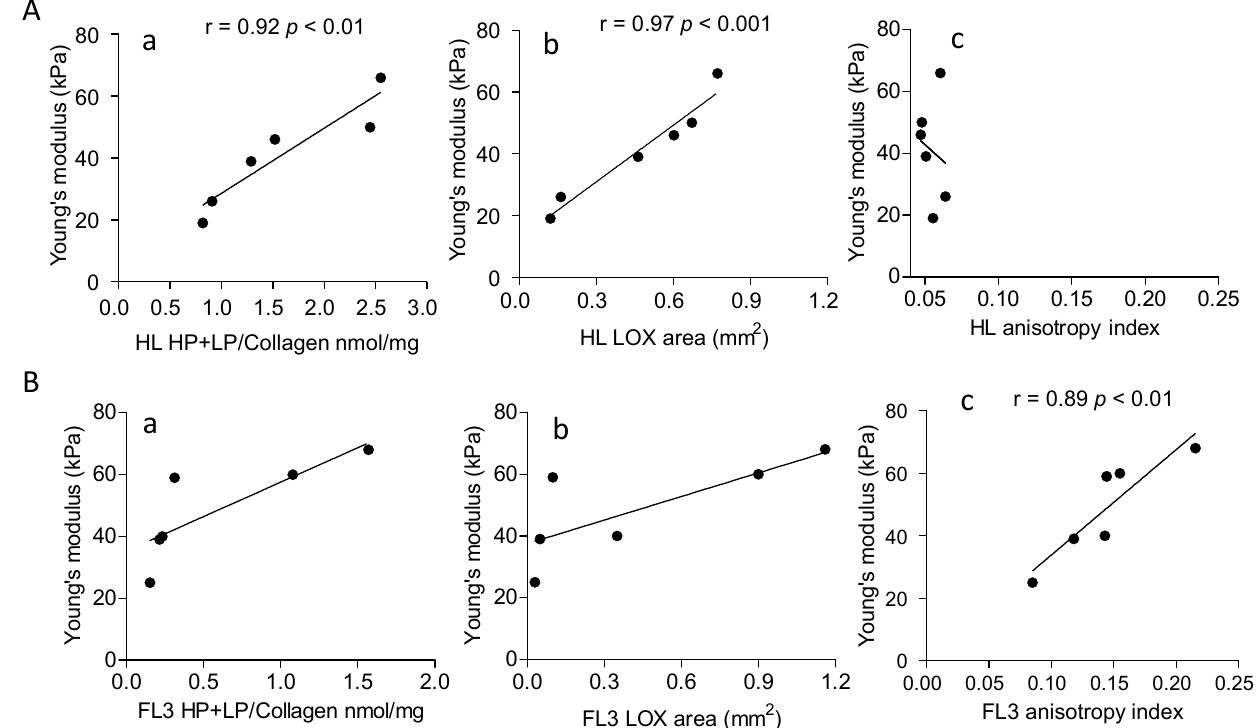
Figure 6. Correlation between Young’s modulus and collagen cross-linking, LOX expression or anisotropy in HL and NHL FL3. 6 HL (Panel ( A )) and 6 NHL FL3 (Panel ( B )) were analyzed. Subpanels a: HL and NHL FL3A collagen cross-linking (HP + LP/collagen nmol/mg) was evaluated as described in the Methods section and data analyzed for the correlation with Young’s modulus (kPa) measured as described. Subpanels b: in situ LOX expression in LN from HL and NHL FL3 was calculated as reported in the Methods, expressed as mm 2 of LOX + area (analyzed with the Aperio algorithm and quantified by the ImageScope software) and compared to the Young’s modulus (kPa). Subpanels c: anisotropy index evaluated as described in the Methods was analyzed for the correlation with the Young’s modulus. Linear regression (r) and significance ( p ) were calculated (Pearson correlation coefficient r) with the Graph Pad Prism software 5.